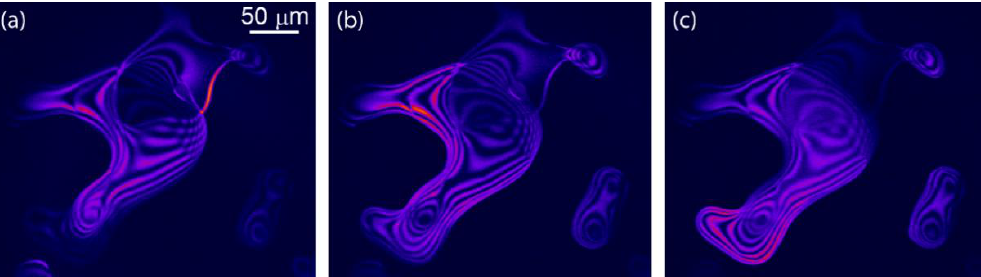
Figure 3. XY scans of as-grown domain structure in nominally pure CVO single crystal, obtained by CSHG, at different focal depths: ( a ) 78 μm, ( b ) 104 μm, ( c ) 143 μm.